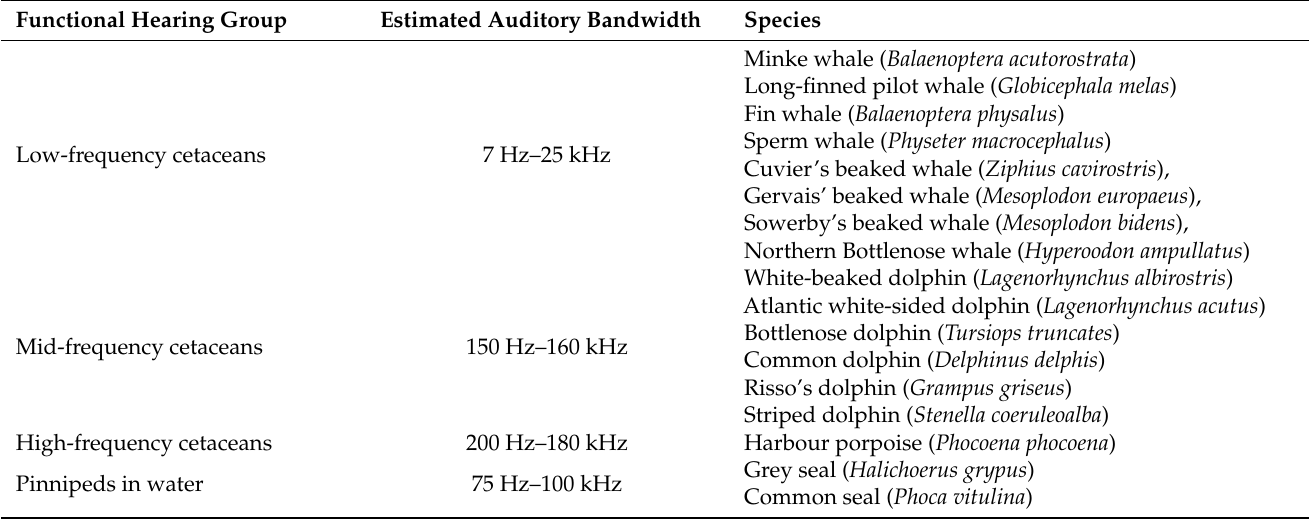
Table 1. Functional cetacean and pinniped hearing groups including examples of species found on the UK Continental Shelf. Functional Hearing